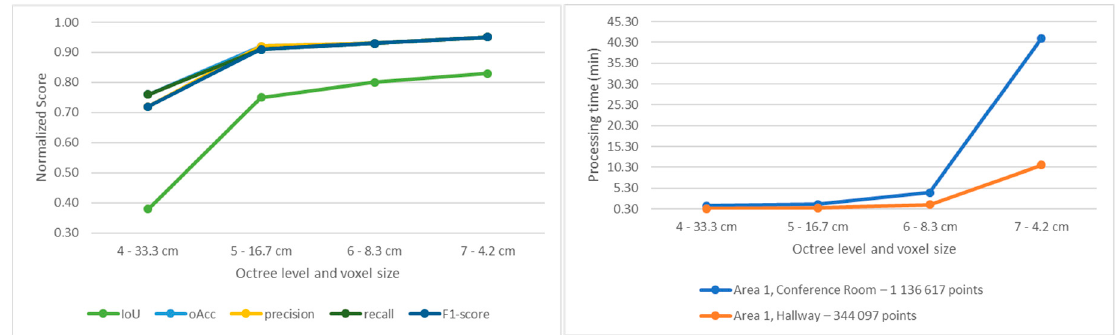
Figure 15: Normalized score and processing time in function of the defined octree level. Figure 15. Normalized score and processing time in function of the defined octree